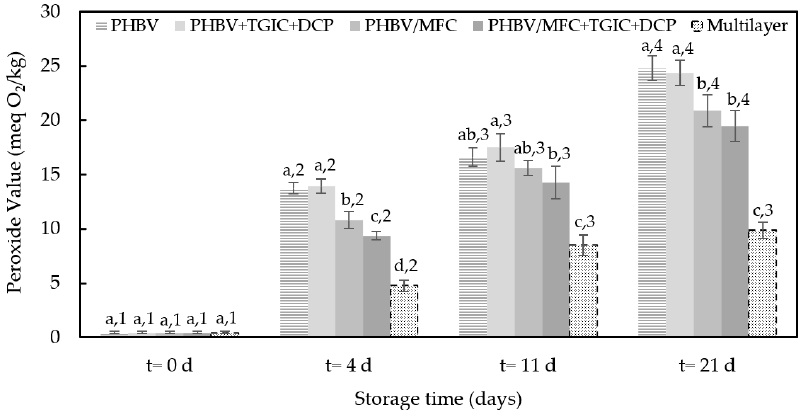
Figure 6. Peroxide values during accelerated storage conditions of the sunflower oil samples pack- aged in trays with the green composite lid films of poly(3-hydroxybutyrate- co -3-hydroxyvalerate) (PHBV) with microfibrillated cellulose (MFC) and compatibilized with triglycidyl isocyanurate (TGIC) and dicumyl peroxide (DCP) and the multilayer commercial film. Different superscripts (a–d) indicate significant differences among samples for the same storage time and different superscripts (1–4) indicate differences due to storage time for the same sample ( p < 0.05).